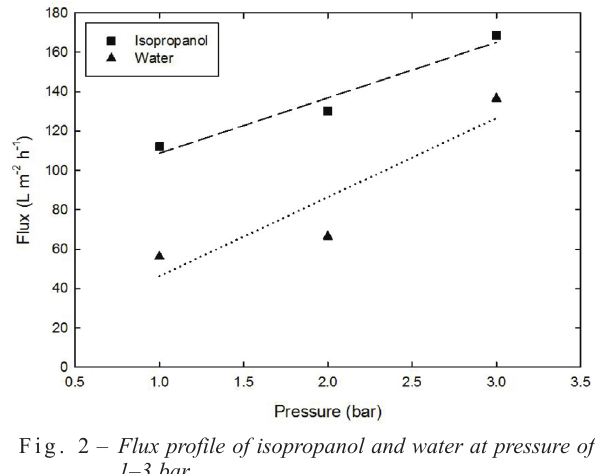
Fig. 2 – Flux profile of isopropanol and water at pressure of 1–3